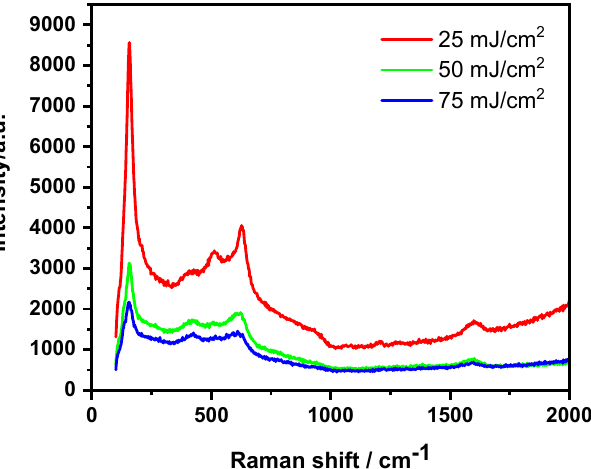
Figure 6. Raman spectra recorded for laser-treated amorphous TNTs. Reprinted with permission from [55].